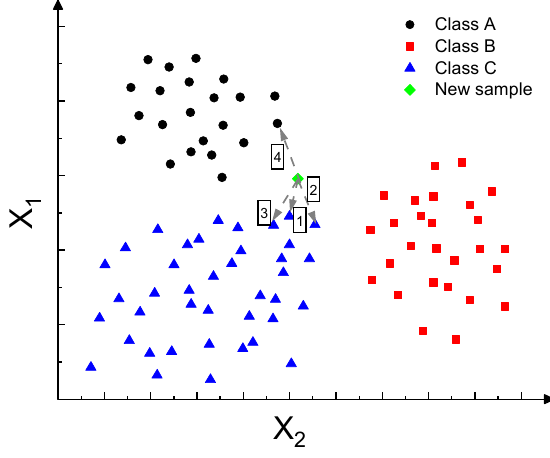
Figure 6. An illustration of K-nearest neighbor (KNN).